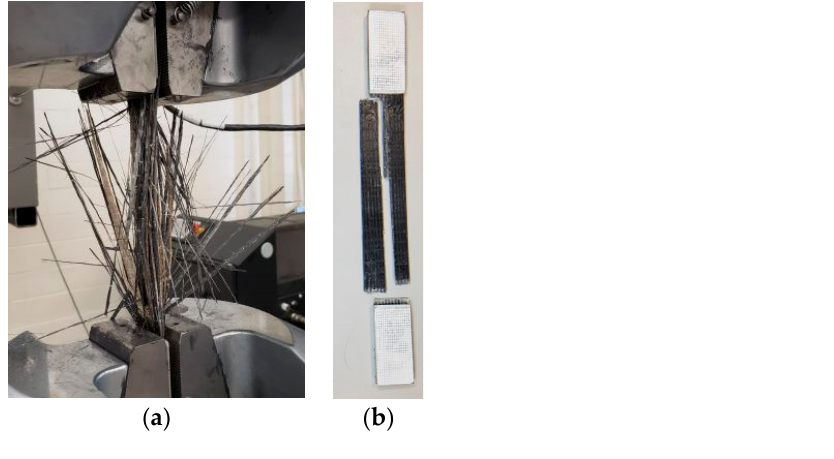
Figure 4. Failed specimen during tensile test ( a ) inter-ply ( b ) intra-ply flax-carbon hybrid compo- sites.